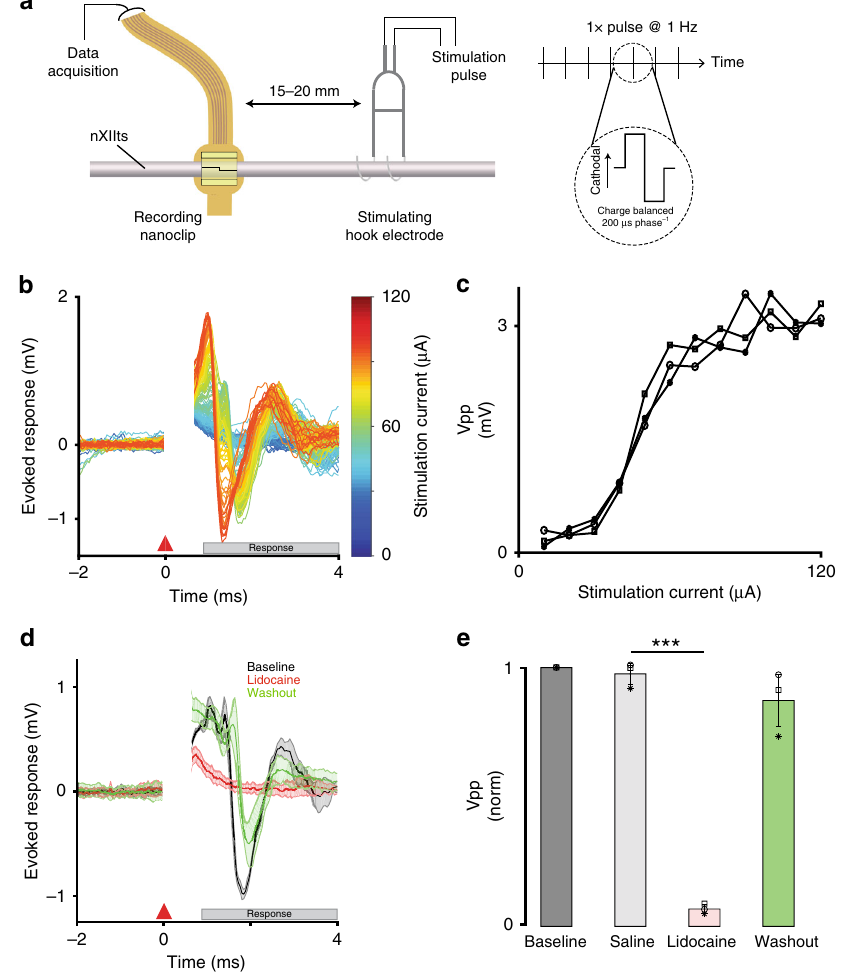
Fig. 3 Nanoclip-anchored thin- fi lm arrays produce high-quality electroneurograms in acute preparations. a Schema for acute recording of evoked compound action potentials. (Left) Current-controlled stimulation was delivered via bipolar silver hook electrodes; evoked responses were recorded by a nanoclip interface implanted 15 – 20 mm rostrally. (Right) Biphasic, cathodal-leading stimulating pulses, 200 μ s phase − 1 at 10 – 120 μ A, were delivered at 1 Hz for 16 – 24 trials. b Example of graded evoked response to increasing stimulation intensities. Stimulation applied at t = 0 ms; stimulation artifact appears t = 0 – 0.5 ms; evoked response follows. c Evoked response peak-to-peak voltage (Vpp) showed an expected sigmoidal relationship with stimulation intensity. Each data point indicates the mean across trials within an animal ( n = 3 birds; 16 – 24 trials each per stimulation intensity). Symbols identify individual birds. d Example of stimulation evoked responses recorded before, during, and after local lidocaine application. Each condition shows mean ± SEM (shaded) for n = 16 trials; all responses evoked at 64 μ A. e Evoked response peak-to-peak voltage for different experimental conditions. Response amplitudes were normalized to baseline condition to facilitate comparison across n = 3 animals. Each data point indicates the mean across 16 trials within an animal; symbols identify individual birds. Bars and error bars denote mean ± SEM across n = 3 birds per condition. Repeated-measures ANOVA, P =